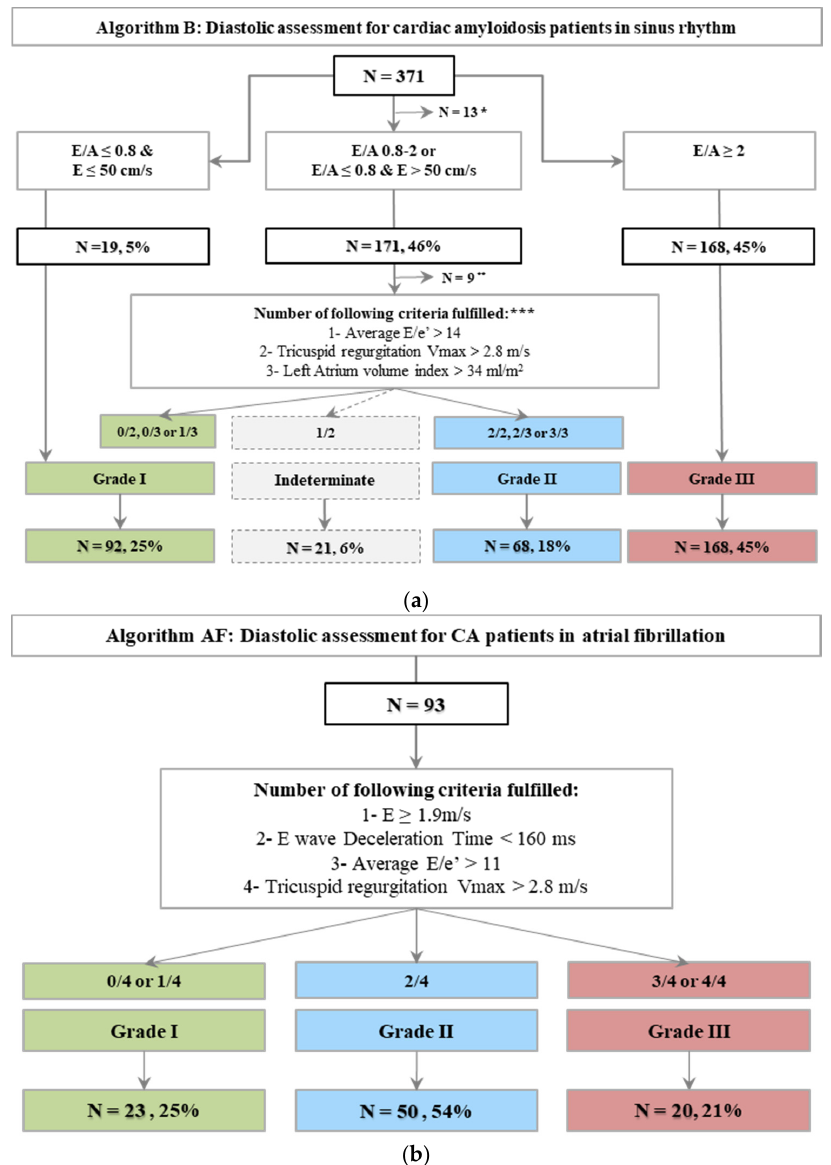
Figure 2. Diastolic function patterns according to LVEF, presence of myocardial disease and rhythm. ( a ) ASE/EACVI Al- gorithm B: Diastolic assessment for cardiac amyloidosis patients in sinus rhythm. ( b ) ASE/EACVI Algorithm AF: Diastolic assessment for CA patients in atrial fibrillation.* 13 patients without available E/A ratio (5 with no mitral inflow, 8 without A wave despite sinus rhythm), ** 9 patients with insufficient criteria for accurate evaluation of diastolic function, *** if available.